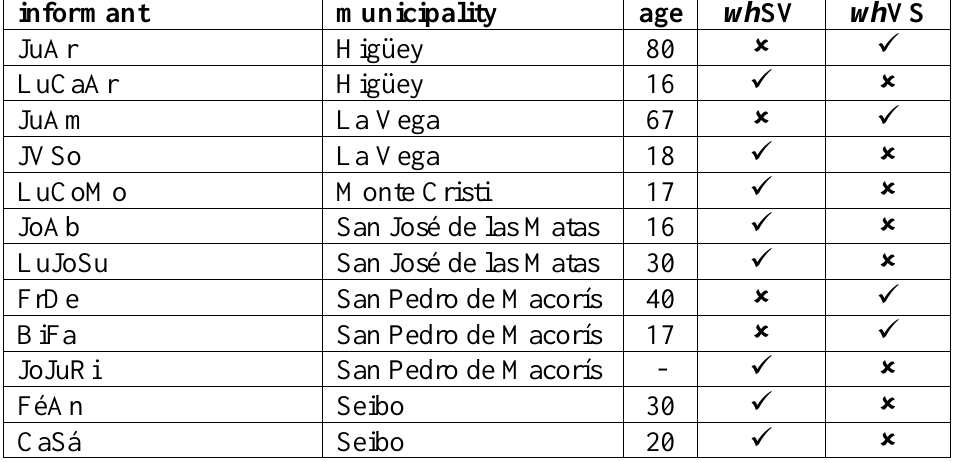
Table (8): Informants employing tú and/or usted in direct non-cleft non-argumental wh - interrogatives